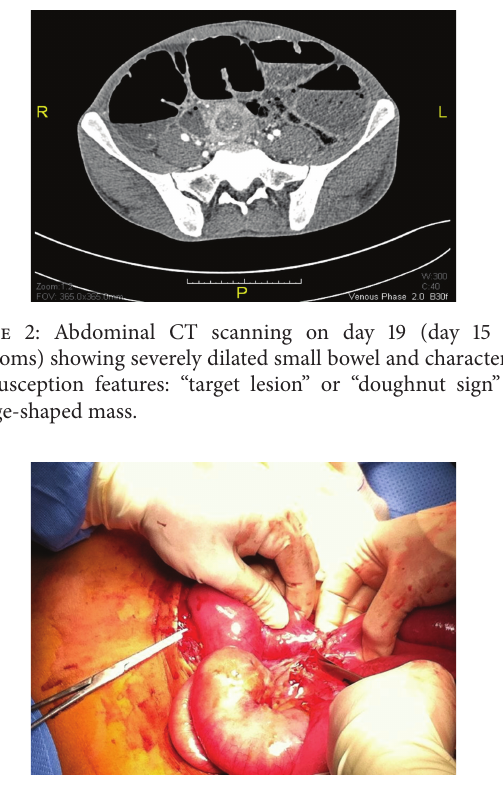
Figure 3: Intraoperative findings showed intussusception at ileoce- cal junction with perforation of small